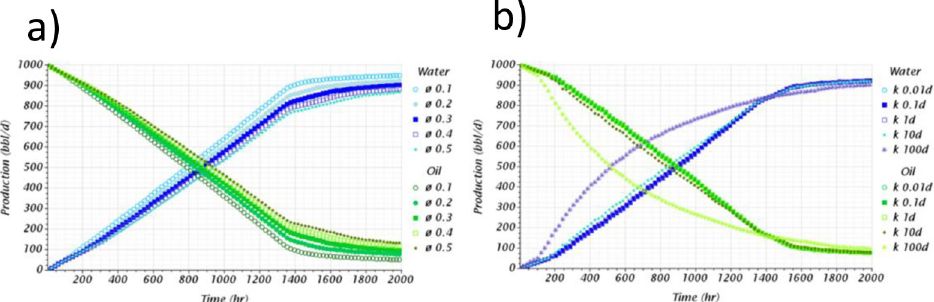
Fig 7. Production profile obtained for the a) porosity and b) permeability sensitivity